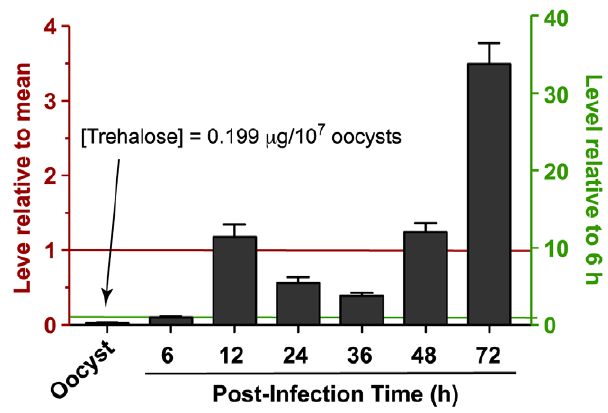
Figure 6. Relative levels of Cryptosporidiumparvum trehalose-6P synthase-trehalose phosphatase ( CpT6PS-TPase ) gene ex- pressed as determined by real-time quantitative RT-PCR in mature oocysts and intracellular developmental stages in HCT- 8 host cells for various post-infection times. The levels of CpT6PS- TPase transcripts were first normalized with those parasite 18S rRNA and then displayed as relative to the overall mean (left-side Y-axis) and to the level at 6 h post-infection (right-side Y-axis). The detected trehalose concentration in the parasite oocysts is also indicated.